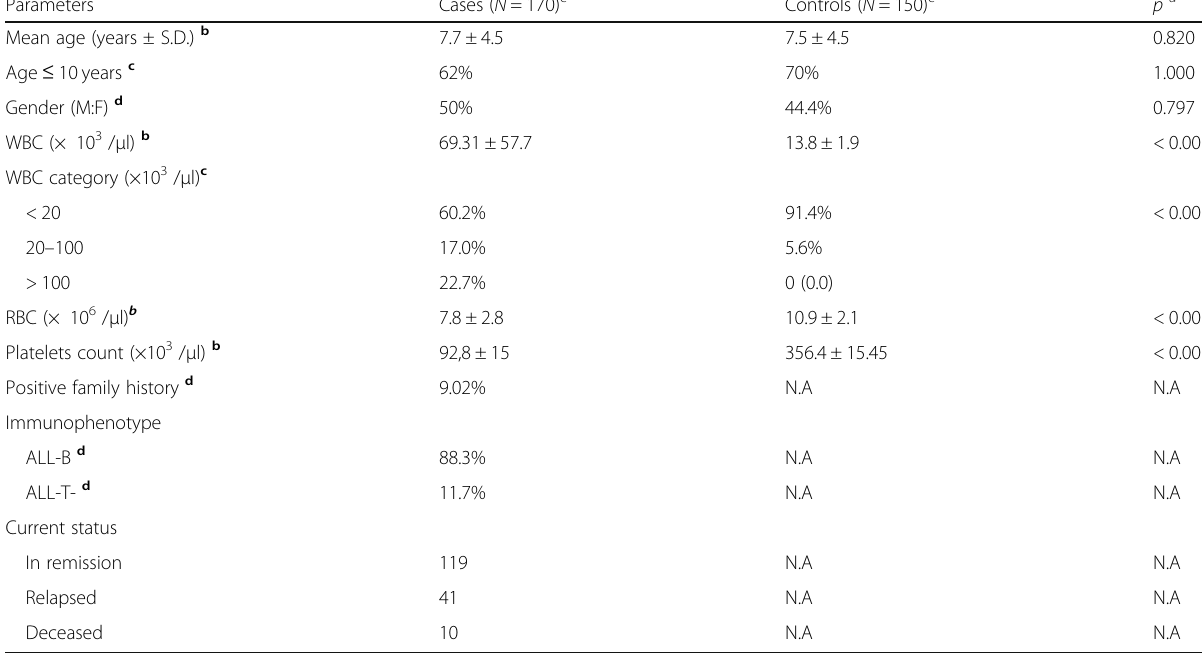
Table 1 Characteristics of study